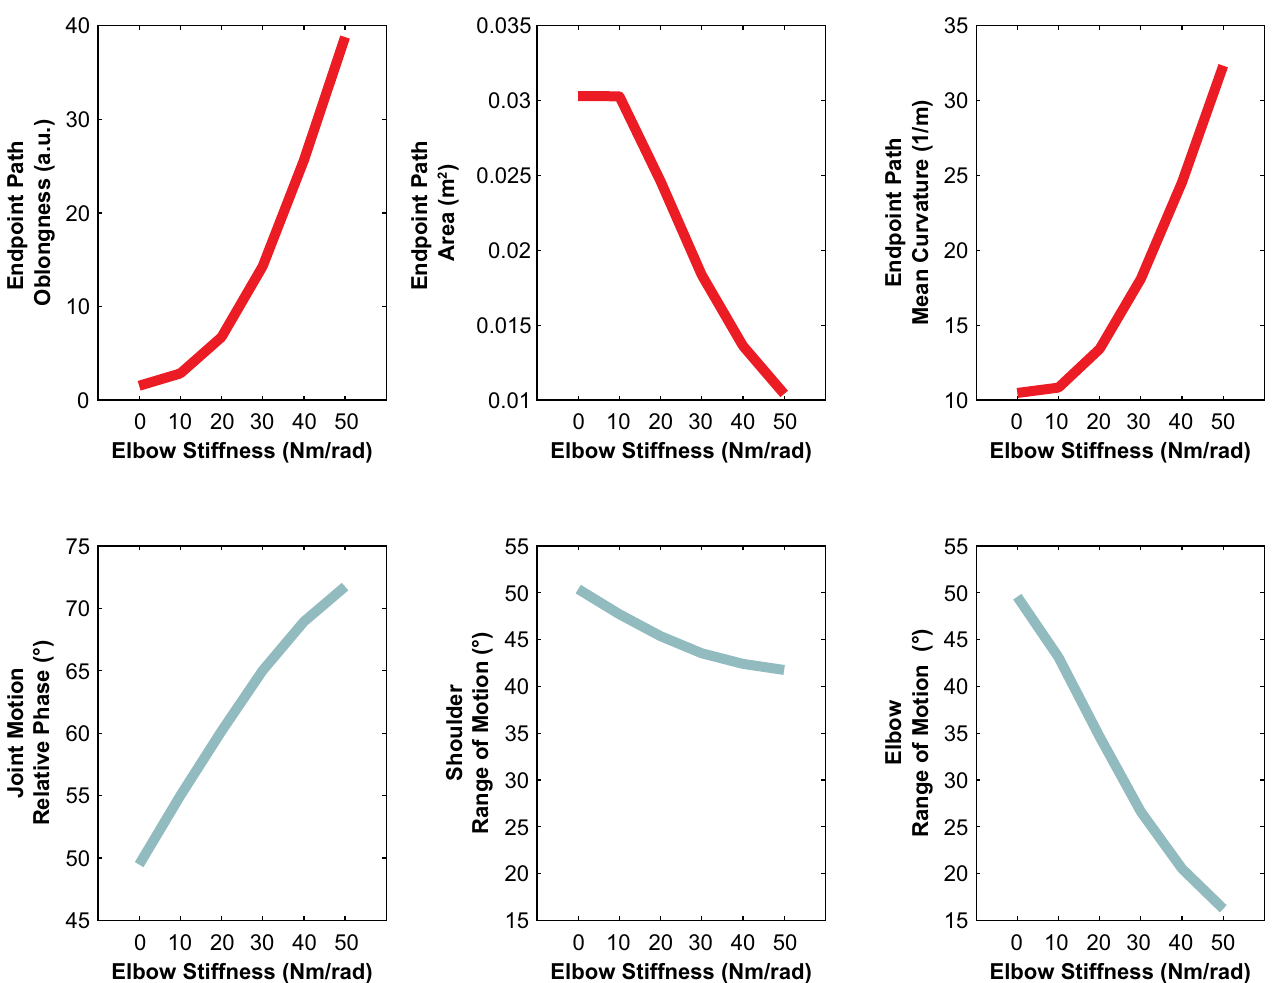
Fig 14. Change in motion related features with simulated elbow stiffness (adapted from [6]) (A) Endpoint path oblongness was defined as the ratio of the eigenvalues of the covariance matrix of the endpoint path in Cartesian coordinates. (B) Endpoint path area was defined as the area enclosed by the end-point path in Cartesian coordinates. (C) Endpoint path mean curvature was defined as the average inverse of the radius of curvature (see Methods). (D) Joint motion relative phase was defined as the relative phase between the elbow and shoulder motion and was calculated using cross-correlation analysis. (E) Shoulder range of motion (ROM). (F) Elbow range of motion